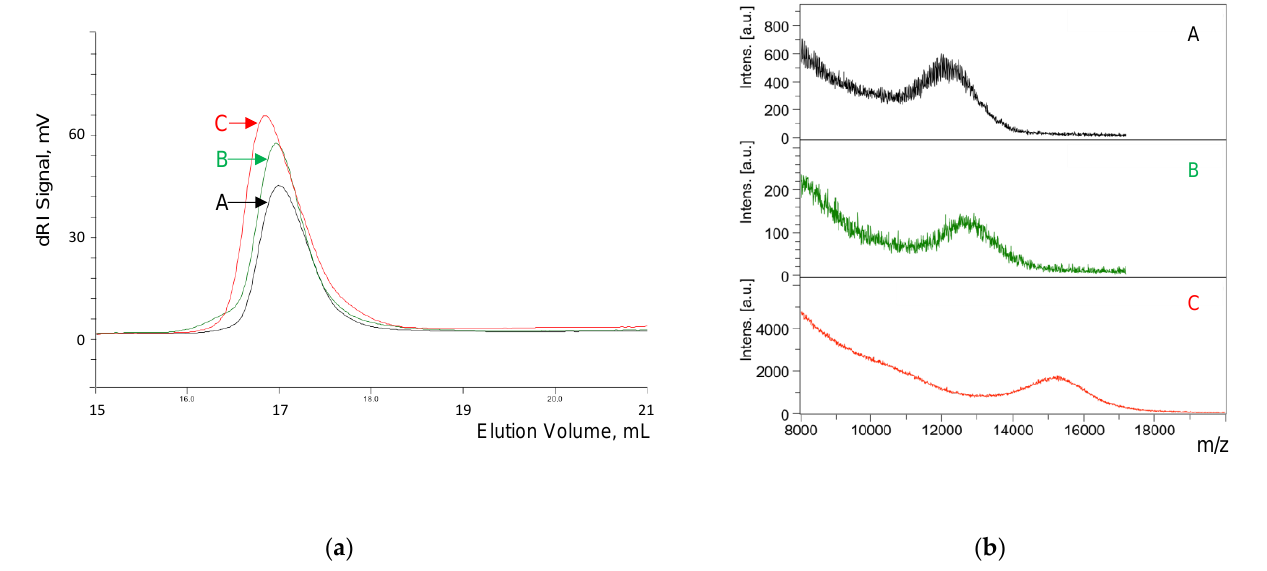
Figure 3. Analysis of starting material PEG11k, A, intermediate (alkyne)−PEG11k−(alkyne), B, and final product (G2) 2 −PEG11k−(G2) 2 , C: ( a ) Overlay of SEC eluograms; ( b ) Overlay of MALDI-TOF